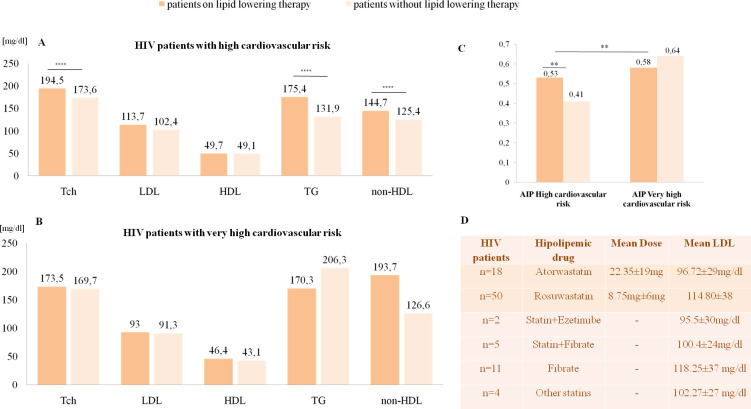
(A) Mean lipid parameters in patients with high cardiovascular risk. All patients in high cardiovascular risk (n = 360), those on lipid lowering therapy (n = 69) and those without lipid lowering treatment (n = 297). Tch–Total Cholesterol, TG–Triglycerides. The exact p-values were: Tchp<0.0001, LDL p = 0.0584, HDL p = 0.9164, non-HDL p<0.0001, TG p<0.0001(B) Mean lipid parameters in patients with very high cardiovascular risk. All patients at very high cardiovascular risk (n = 29) on lipid lowering treatment (n = 23) and without lipid lowering therapy (n = 6). Tch–Total Cholesterol, TG–Triglycerides. Exact p-values were: Tch p = 0.8236, LDL p = 0.8870, HDL p = 0.7567, non-HDL p = 0.9800, TG p = 0.7437(C) Mean Atherogenic Index of plasma, differences between high and very high cardiovascular risk groups with regard to lipid lowering treatment. The exact p-values were AIP p = 0.0122 for high CV risk patients vs. very high CV risk patients; AIP p = 0.7050 for very high CV risk patients with lipid lowering therapy vs. those without; AIP p = 0.0038 for high CV risk patients with lipid lowering therapy vs. those without. All values are given in [mg/dl] Statistical significance is marked as ** and ****. (D) Lipid lowering treatment type along with mean LDL values.